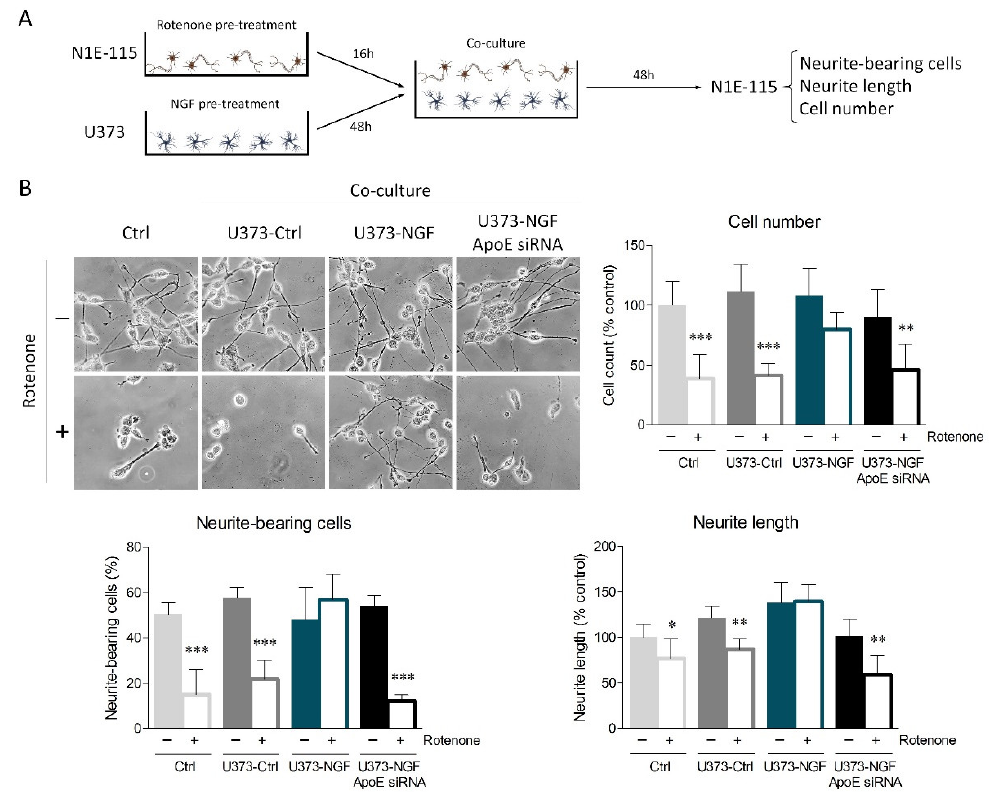
Figure 6. ApoE secretion by NGF-treated U373 cells provides neuroprotection from oxidative stress. ( A ) Representative scheme of astrocyte–neuron co-cultures set up as described in the Materials and Methods Section. Neurite-bearing cells, neurite length, and cell number were assessed 48 h after the establishment of co-culture. ( B ) Representative images in bright field and quantitative assessment of neuronal morphology of N1E-115 cells, previously treated (+) or not (−) with rotenone (0.1 µM) for 16 h. N1E-115 were then kept in fresh DMEM (Ctrl), or co-cultured with control U373 (U373-Ctrl), NGF-pre-treated U373 (U373-NGF), and NGF-pre-treated U373 silenced for ApoE (U373-NGF ApoE siRNA) for 48 h. n = 5 different experiments. Data represent means ± SD. Statistical analysis was carried out by using one-way ANOVA, followed by Tukey’s post hoc test. * p < 0.05, ** p < 0.01, *** p < 0.001.